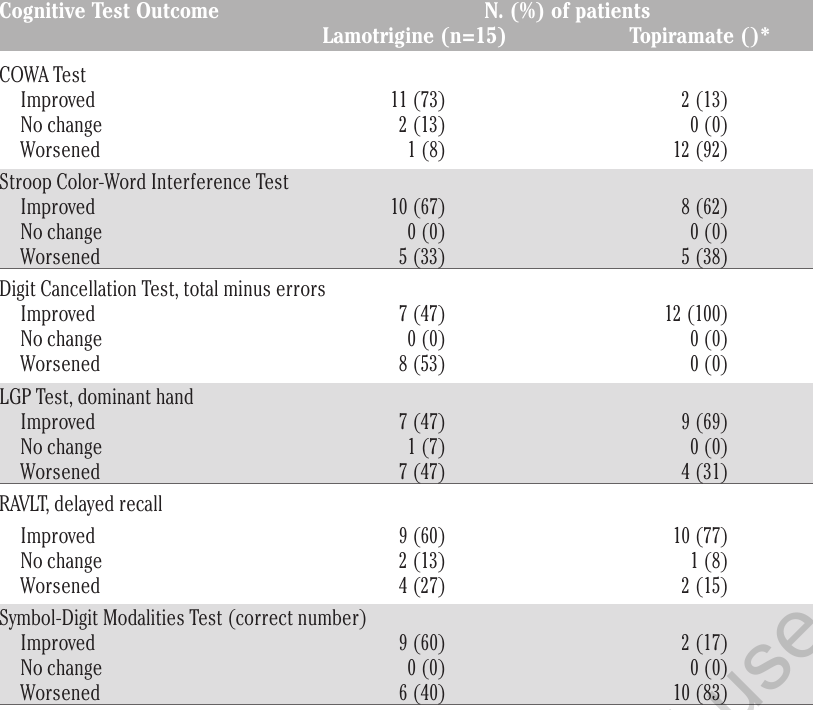
Table 4. Proportion of patients improving, having no change, or worsening from base- line to Week 16 for each cognitive test. Cognitive Test Outcome